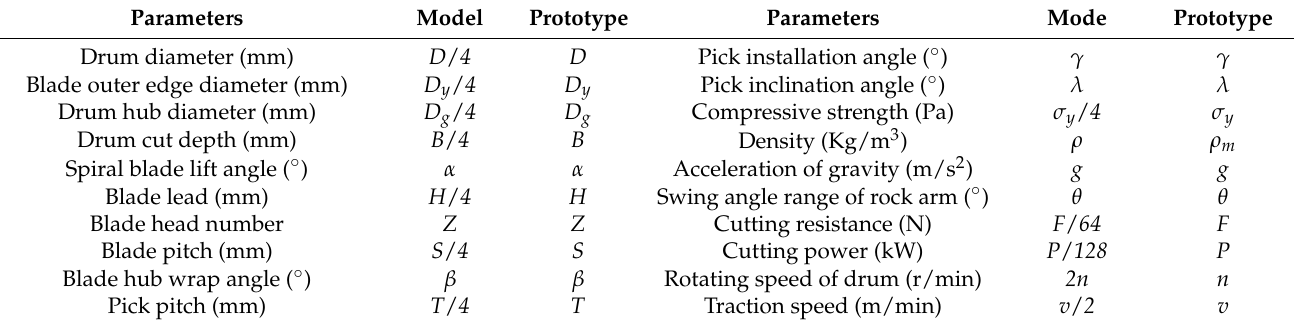
Table 2. Similarity coefficients of the simulated shearer cutting system.